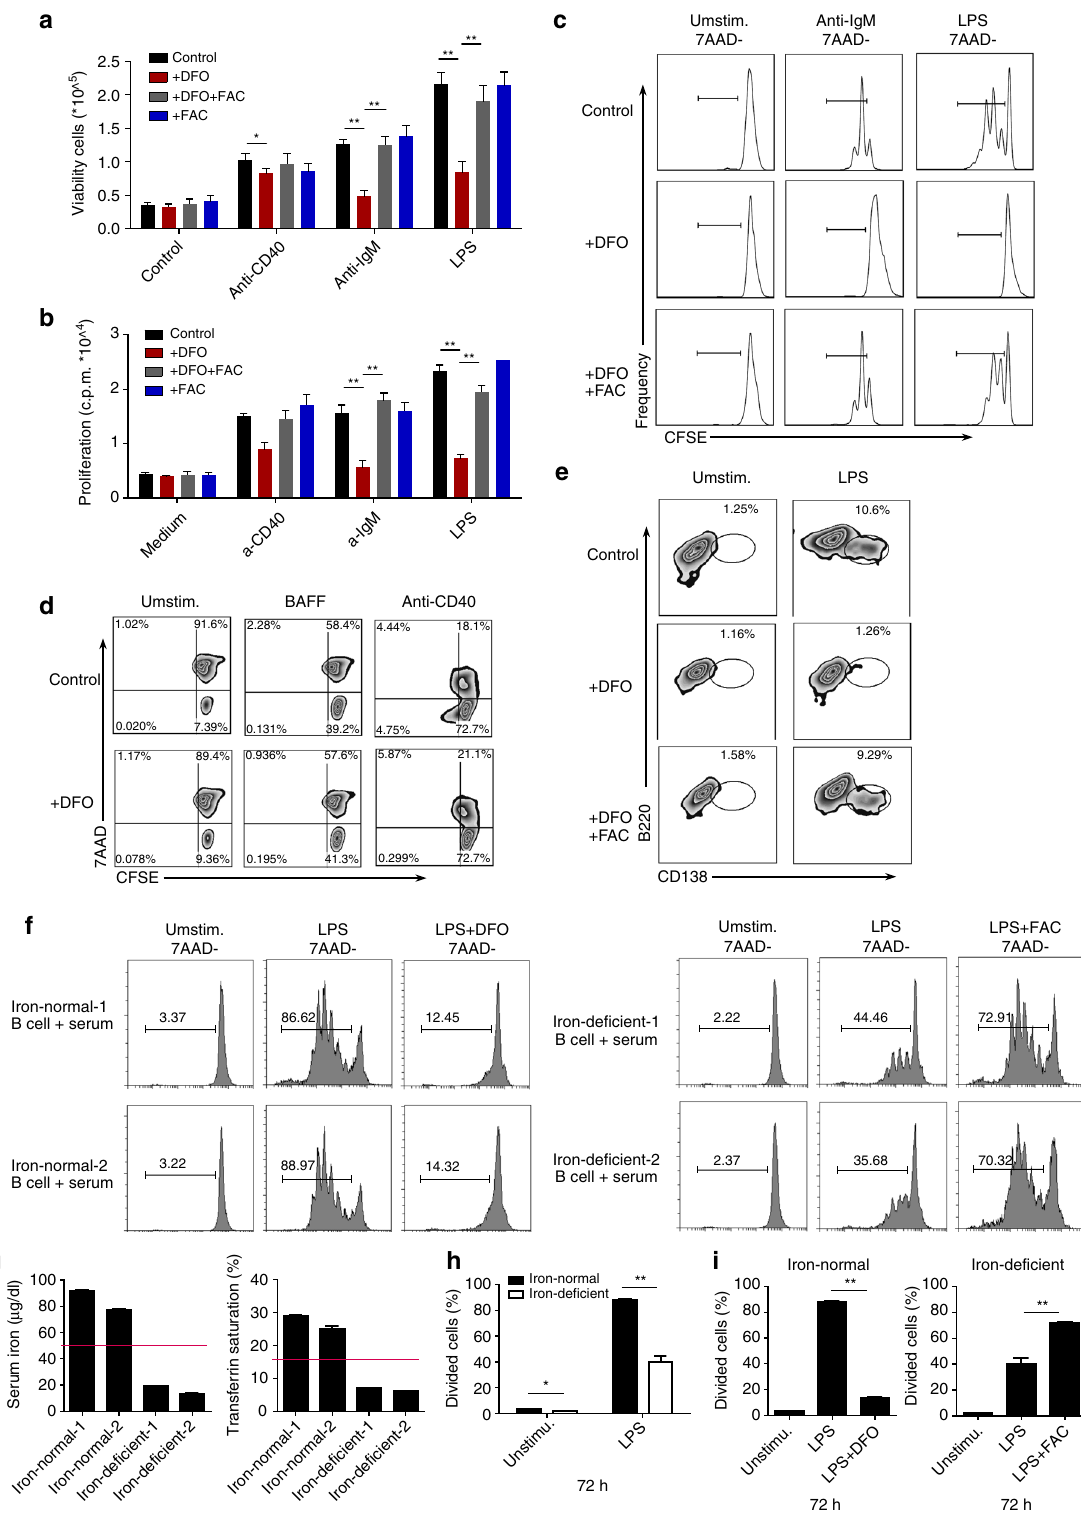
cells compared with control B cells (Fig. 6a). Thus, we conducted a 5-bromo-2-deoxyuridine (BrdU) incorporation assay to assess cell cycle progression in response to anti-IgM or LPS and found that iron-de fi cient B cells exhibited G1/S arrest (Fig. 6b). Cyclins play crucial roles in the regulation of cell cycle entry and cell cycle progression, and two cycle-related genes, cyclin D and cyclin E, are critical for S phase entry of activated B cells 22